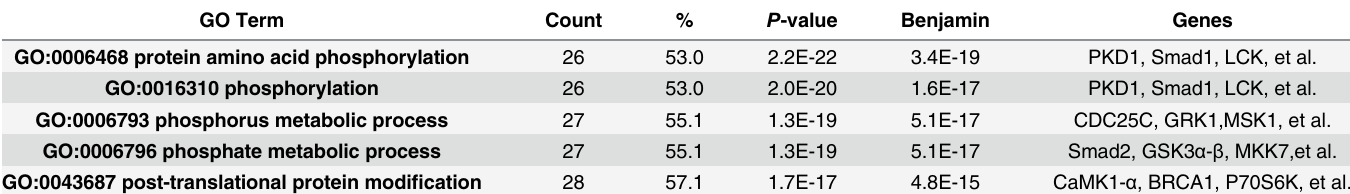
Table 3. Gene Ontology analysis (top five): biological